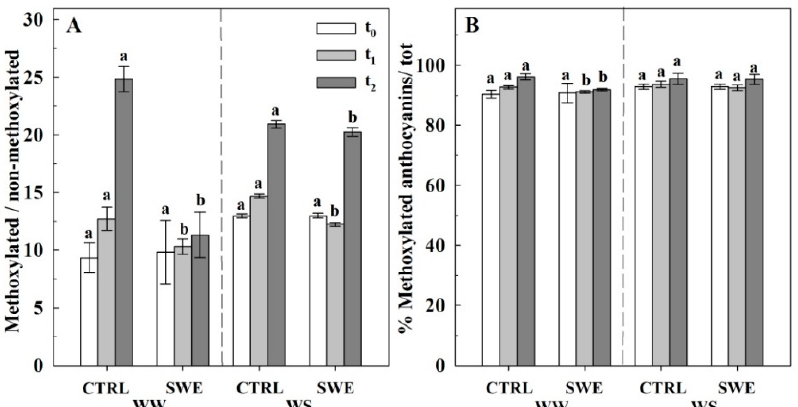
Figure 4. Berry skin anthocyanins methoxylation in V. vinifera treated with A. nodosum extract (SWE) and untreated plants (CTRL) under two irrigation regimes (WW, well-watered; WS, water stressed). ( A ) Methoxylated / non-methoxylated anthocyanins ratio; ( B ) % of methoxylated anthocyanins on total anthocyanin content. Means ( ± SE, n = 5) followed by distinct letters within the same water regime and sampling time are significantly di ff erent according to the LSD test ( p ≤ 0.05). Measurements were conducted at t 0 (white bar), t 1 (grey bar), and t 2 (dark grey bar)